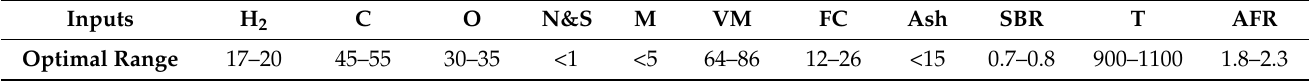
Figure 6. Sensitivity assessments plots (SMH is abbreviation of specific mass flow rate of hydrogen). Table 5. The optimal compositions and conditions for optimal production of